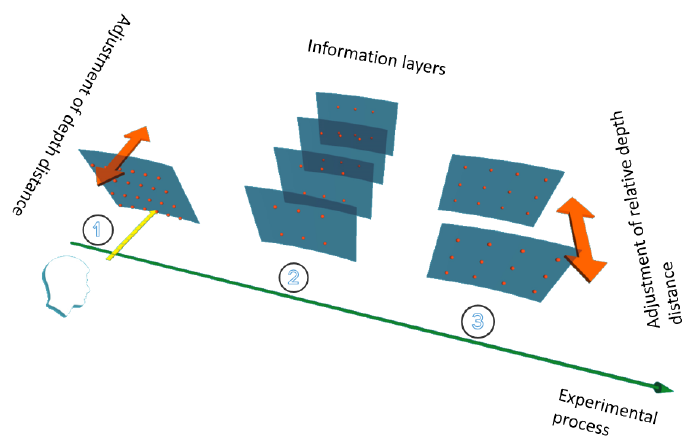
Figure 1. Schematic diagram of the experimental sequence.